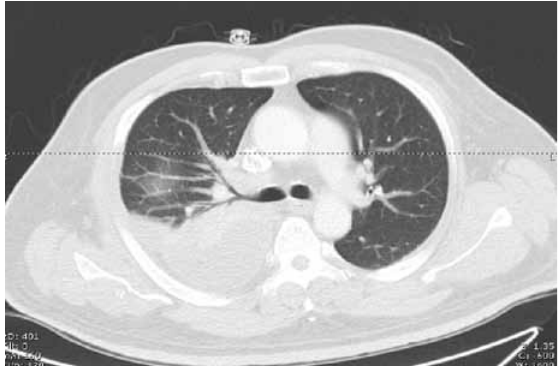
Figure 2. CT Chest: a pleural collection on the right